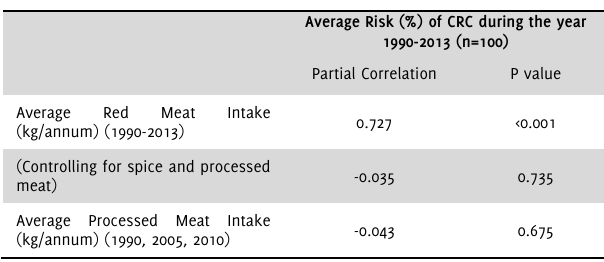
Average Risk (%) of CRC during the year 1990-2013